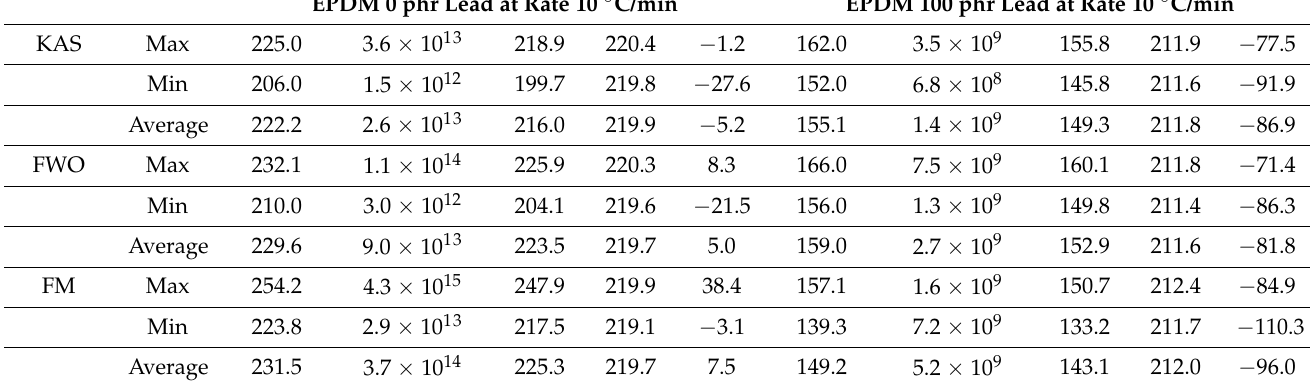
Table 10. Summary of the maximum, minimum, and average values of thermodynamic parameters (enthalpy change, Gibbs free energy change, and entropy change), activation energies (E), and pre-exponential factors (A).